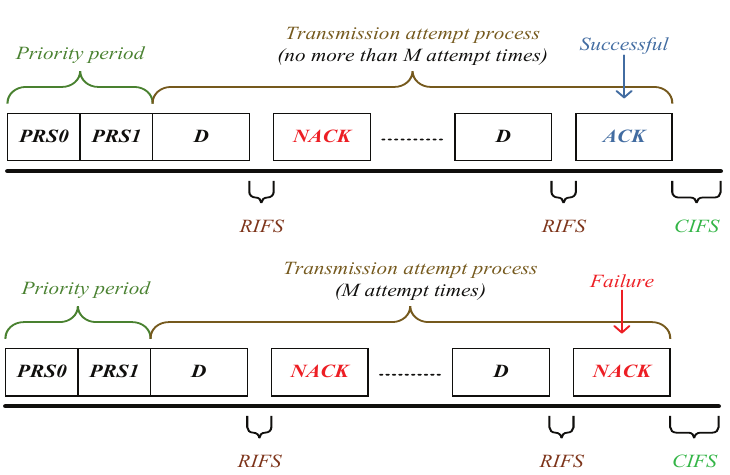
Figure 4. 1901’s time sequence for reliable PLC networks with ARQ